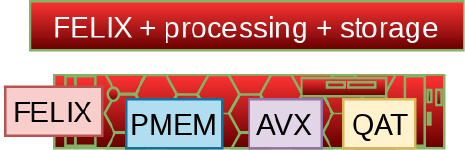
Figure 5. FELIX topology of DUNE favoring high density over routing features: Persistent Memory (PMEM) for bu ff ering and storage, AVX for data processing, and hardware accelerated compression